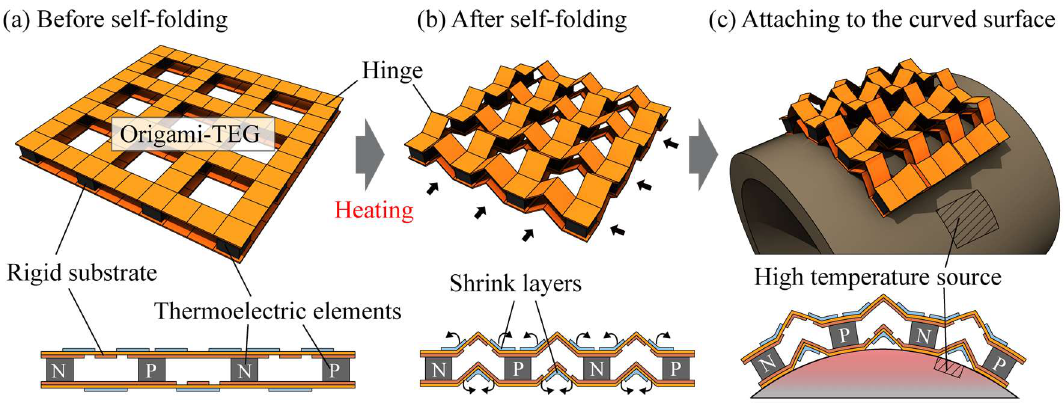
Figure 1. Schematic of origami-type flexible thermoelectric generator (origami-TEG). ( a ) Origami- TEG before self-folding. ( b ) Origami-TEG after self-folding. The shrink layer generates a driving force to fold up by heating and forms an origami structure spontaneously. ( c ) Origami-TEG attached to a curved heat source. The bellows fold structure of the substrate arranged in a grid pattern gives the TEG high flexibility.